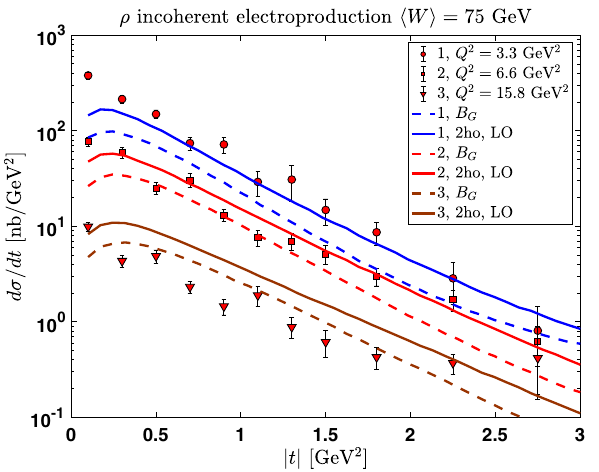
Fig. 13 Differential cross sections for incoherent electroproduction of ρ mesons as a function of the total momentum transfer (square) t . The data refer to the HERA H1 experiment [40] and are compared with present calculations within the QMBA (2 h.o.) (full lines) and the Gaus- sian approximation ( B G ) profiles (dashed lines). In both cases the fluc- tuation parameter B q = 1 . 5 GeV − 2 and LO gluon distributions are used